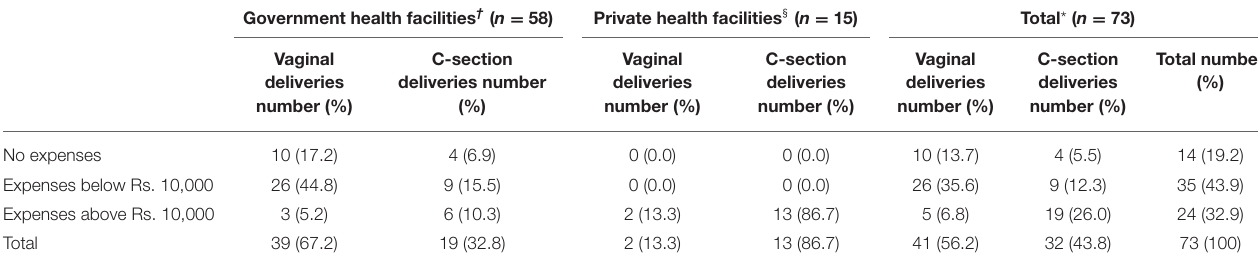
TABLE 3 | Distribution of institutional deliveries according to the type of health facility, type of delivery and expenses incurred for deliveries.